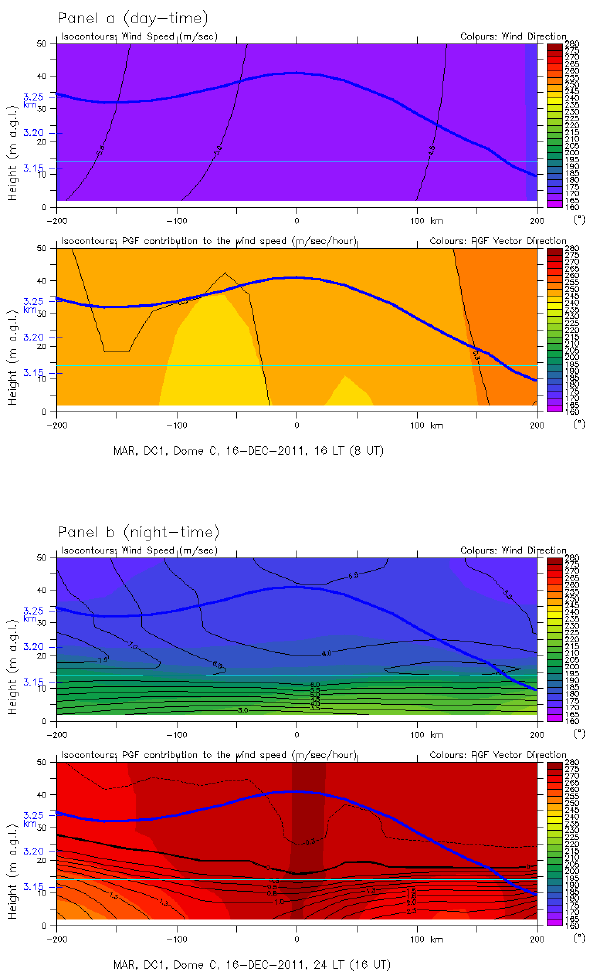
Figure 7. (a) Wind (top) and PGF (bottom) at the end of day-time (16:00LT), along the x axis. The PGF contribution to the wind speed is defined in Eq. (1). PGF vector refers to (PGF u , PGF v ). Domain topography is shown by the thick blue line. The distance from Dome C is in km. The simulated jet level is at z = 14ma . g . l . (cyan line). (b) Same as in (a) but at midnight.